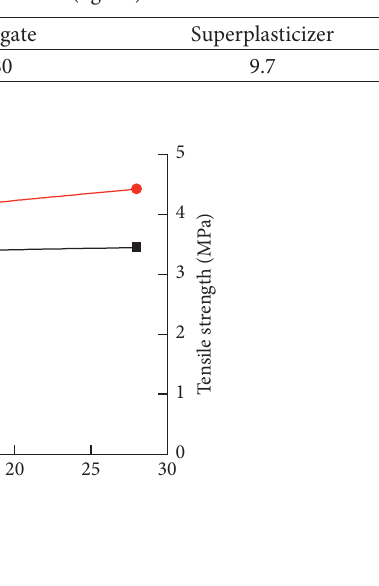
Table 6: Mix proportion of concrete (kg/m 3 ).